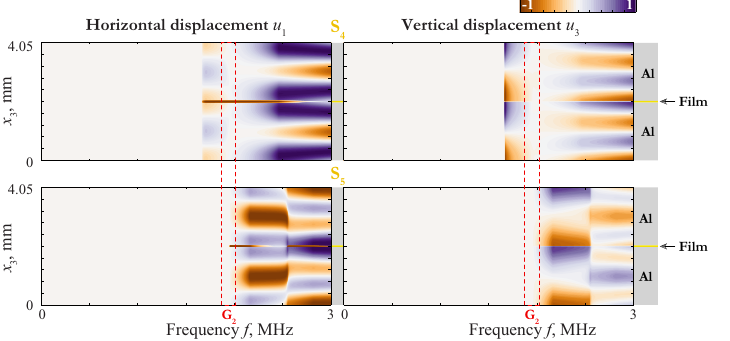
Figure 11. Displacement distribution u k ( x 3 , f ) of SLWs propagating in 4.05 mm thickness plate (2 mm aluminium/50 µ m film/2 mm aluminium) with imperfect contact ( κ 1 = 4.2 GPa/mm, κ 3 = ∞